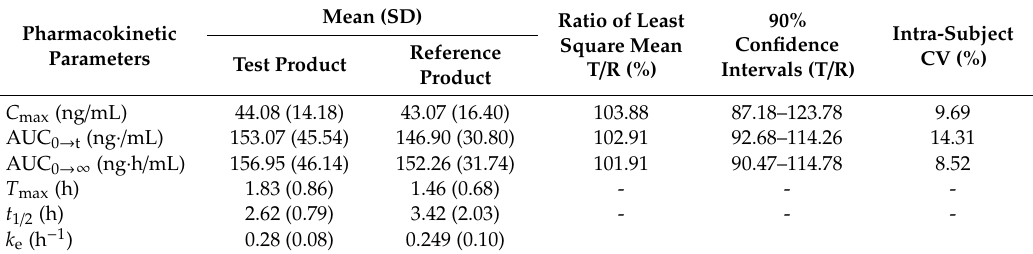
Figure 3. Mean plasma sumatriptan concentration-time curve after oral administration of a single dose of 50 mg of the test product (Generic sumatriptan 50 mg film-coated tablet; Siam Bheasach Co., Ltd., Bangkok, Thailand) and the reference product (Imigran TM tablets 50 mg; GlaxoSmithKline, Poznan, Poland) ( n = 6). Table 6. Pharmacokinetic parameters for sumatriptan after oral administration of a single dose of 50 mg test and reference products to healthy subjects and 90% confidence intervals of those parameters ( n = 6).